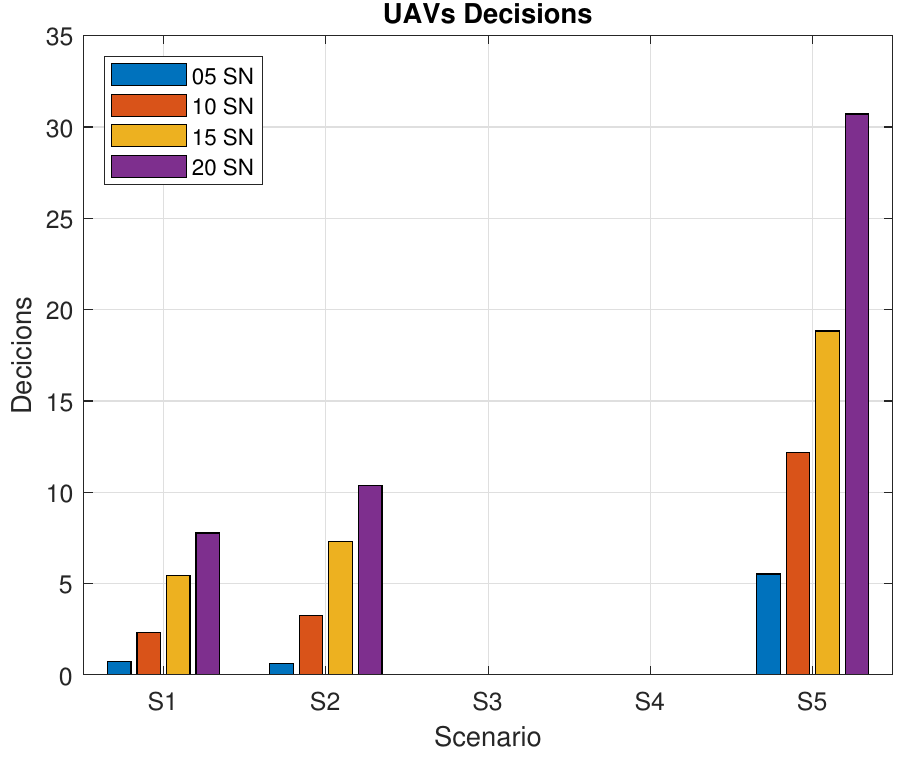
Figure 14. Number of decisions taken by the